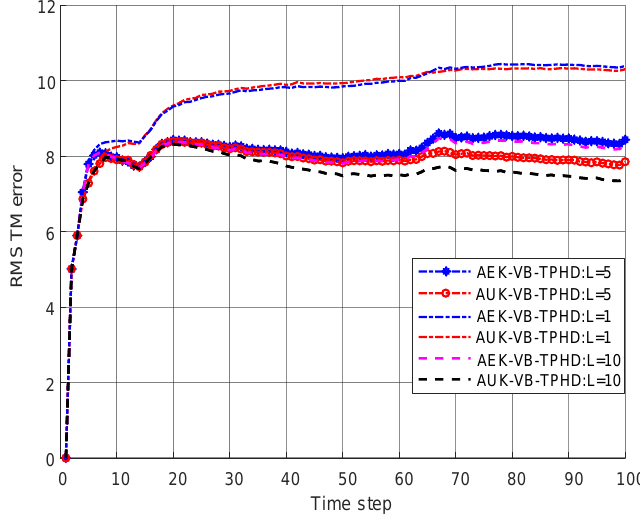
Figure 10. Comparison of RMS TM error under different lengths of update window.